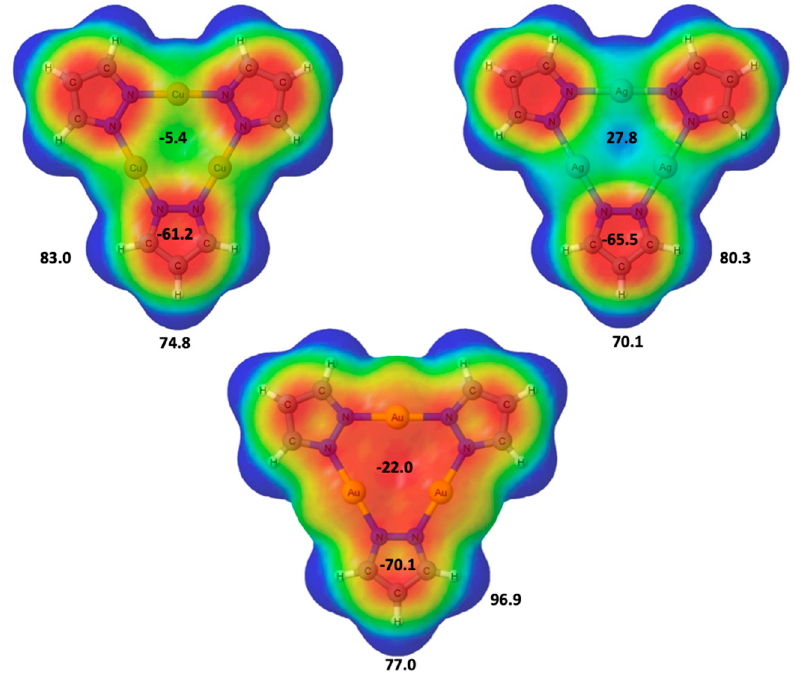
Figure 3. Molecular electrostatic potential of the (Pz-M) 3 compound on the 0.001 au electron density isosurface. The color range associated to the MESP is between red ≤ − 0.020 au and blue ≥ 0.015. Stationary values are given in kJ/mol.